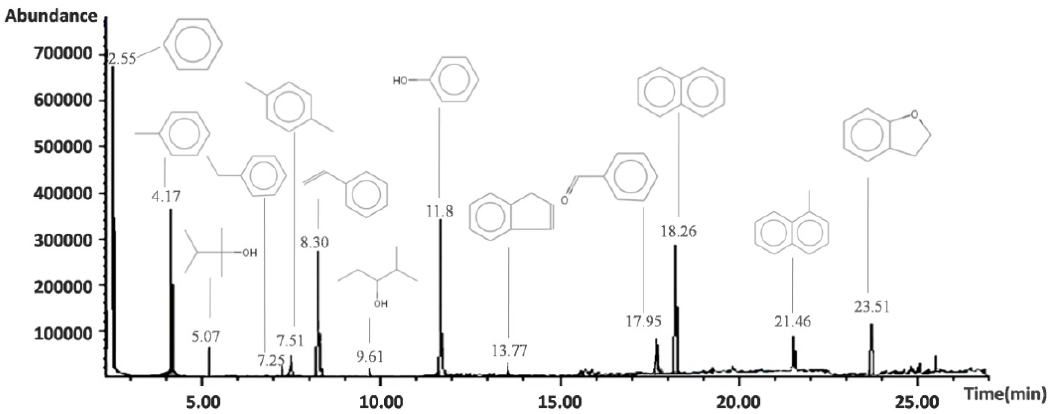
Figure 11. GC chromatogram of a typical sample from sampling port 1.